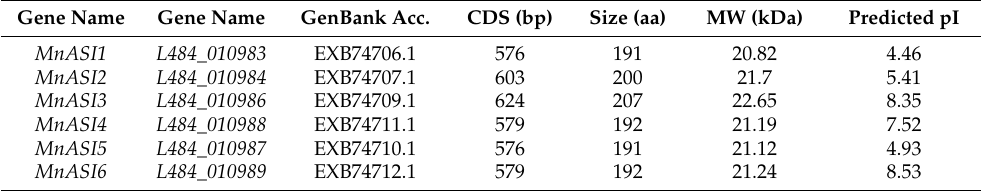
Table 1. Characterization of α -amylase/subtilisin inhibitors in M. notabilis .